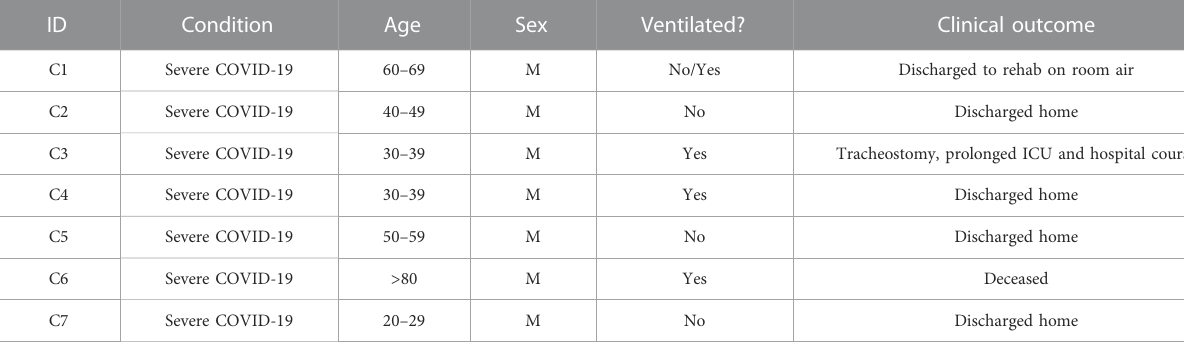
TABLE 1 Characteristics of selected data from COVID-19 patients from Wilk et al.